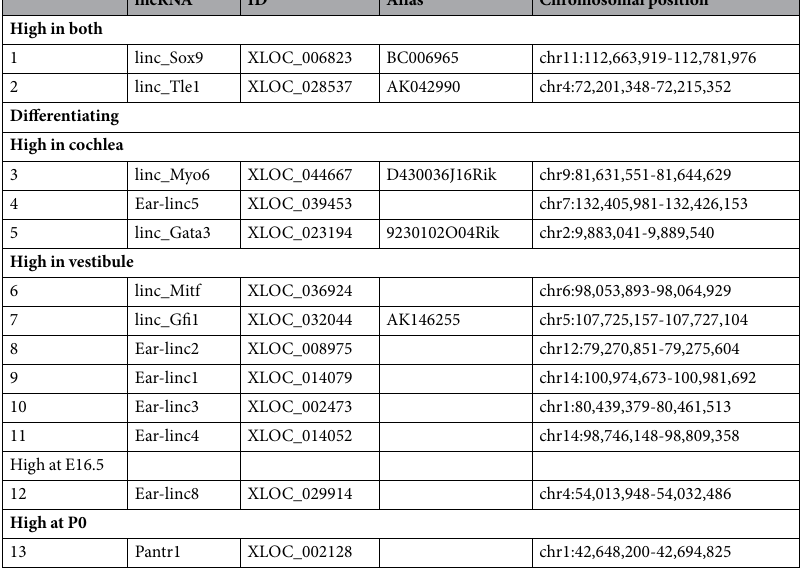
Table 1. Novel and known lncRNAs expressed in the inner